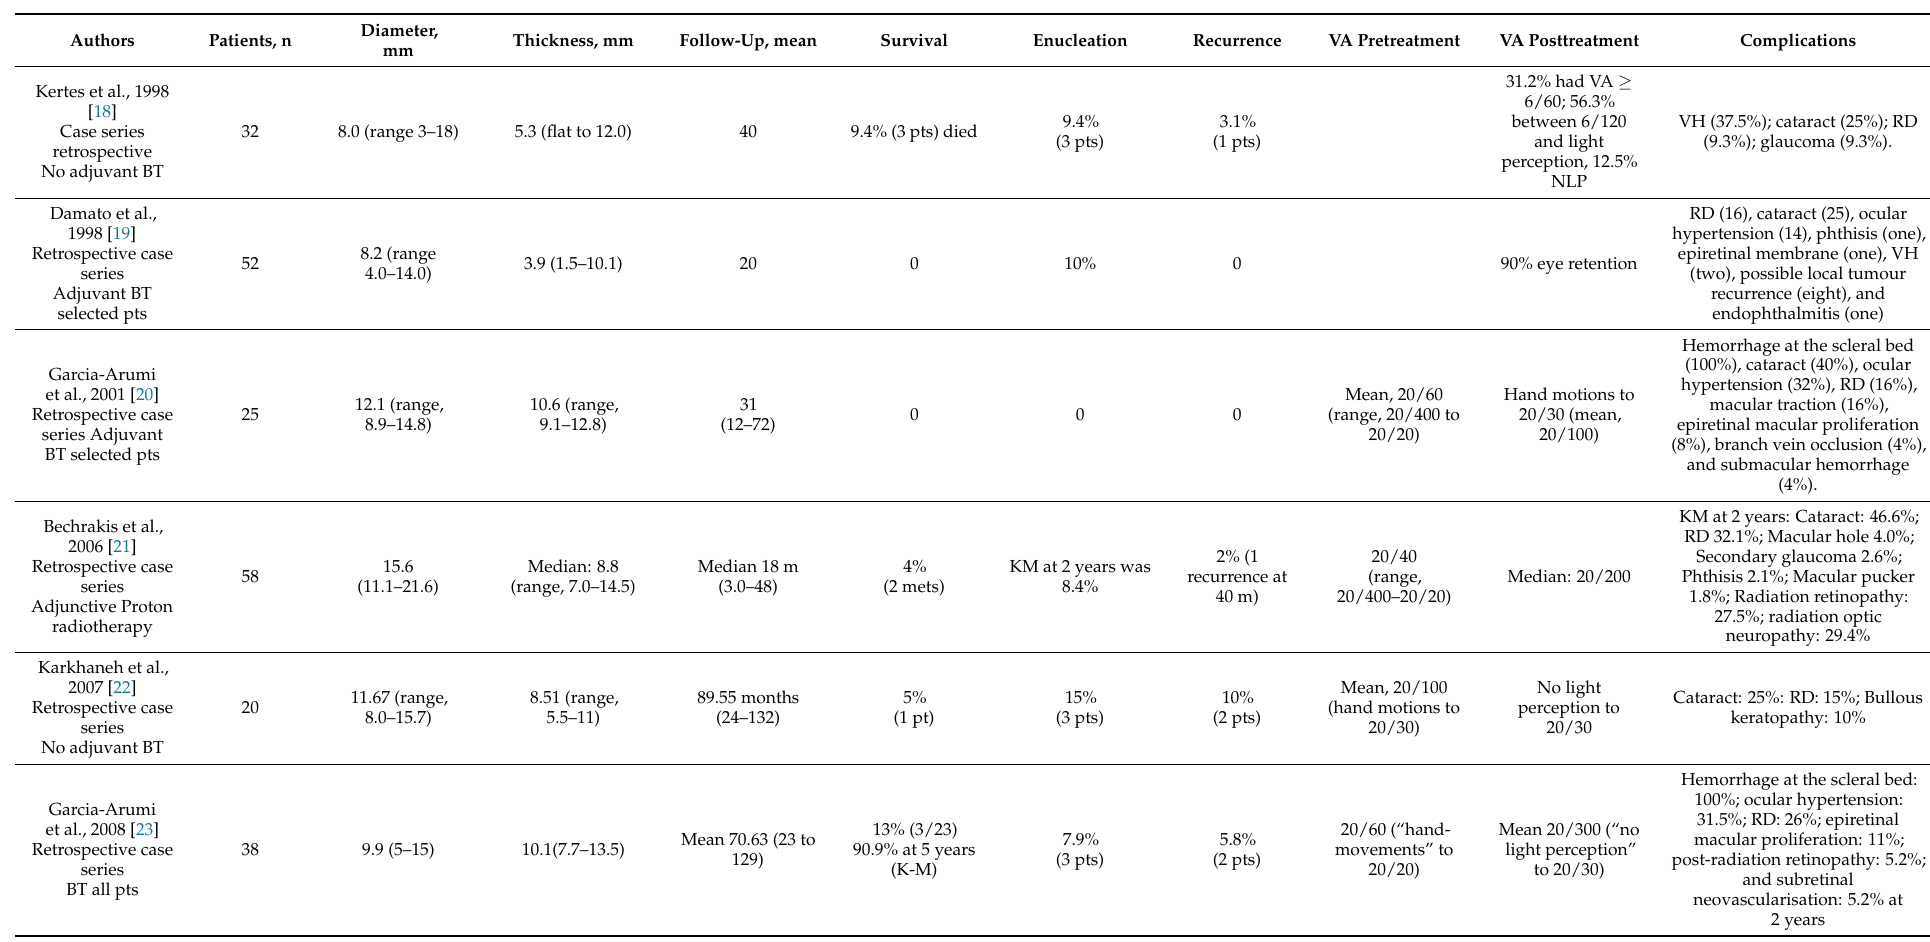
Table 4. Summary of studies on endoresection for uveal